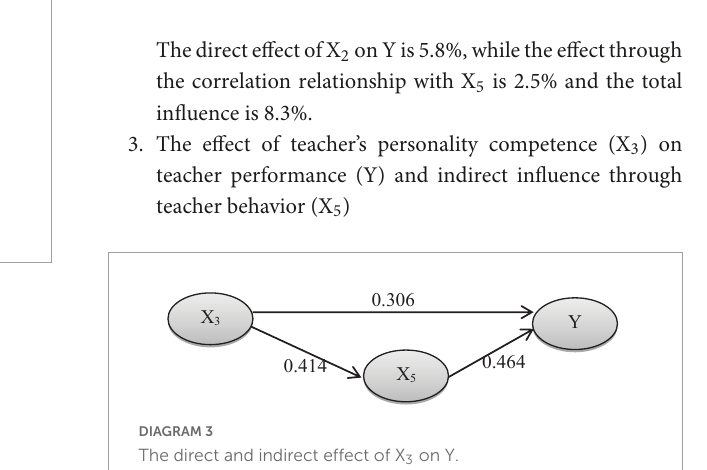
DIAGRAM3 The direct and indirect effect of X 3 on